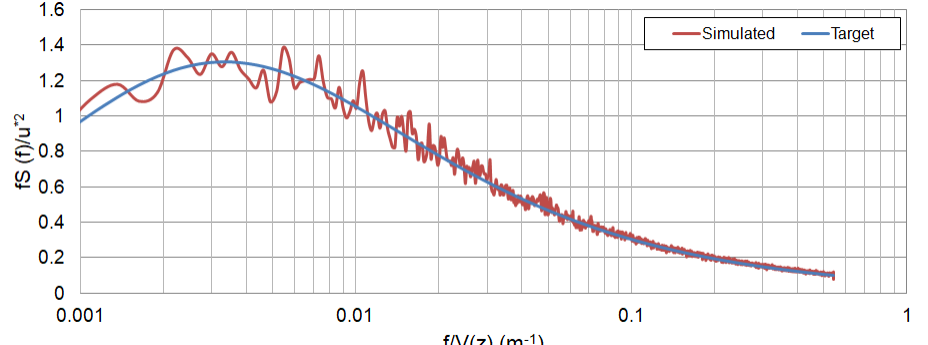
Figure 1. Typical power spectral density of the wind velocity generated for a given position of the